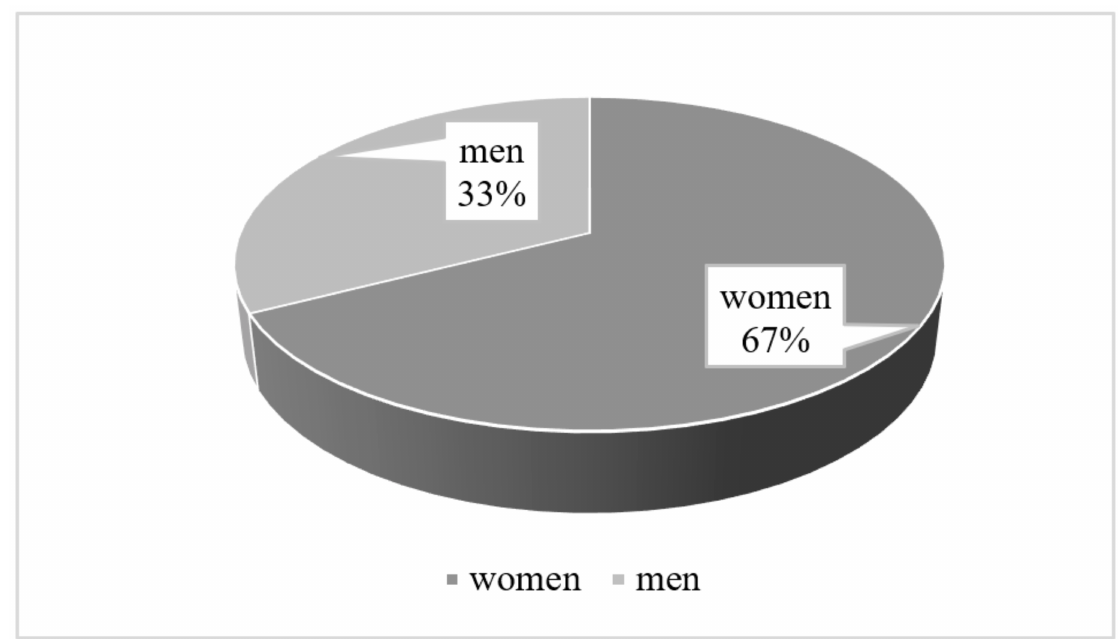
Figure 1. Structure of respondents by gender. Source: own work.